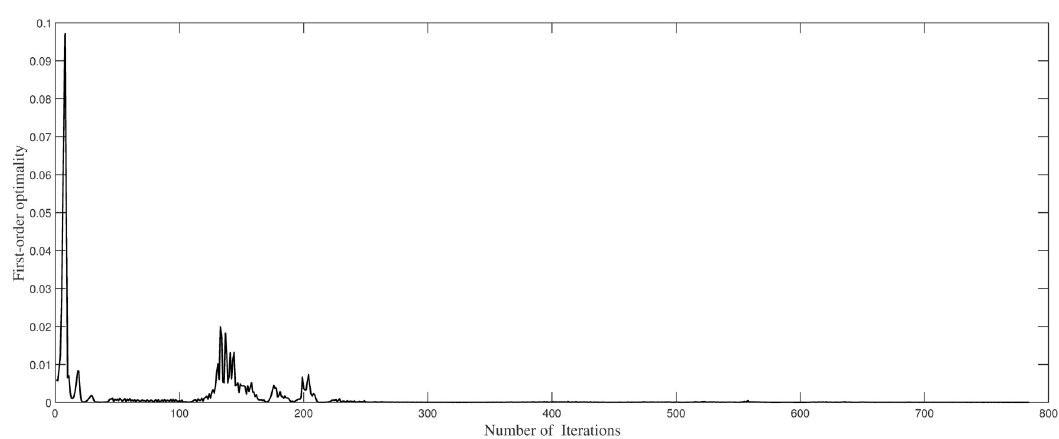
Fig 7. Trend of training the errors with iteration steps in Example 2.